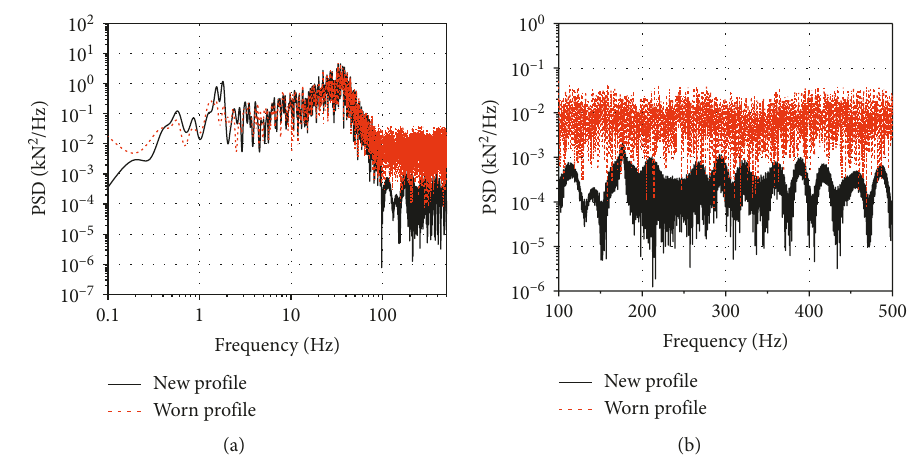
Figure 18: Power spectral density of vertical wheel-rail force: (a) overall; (b) enlarged diagram of 100 ∼ 500